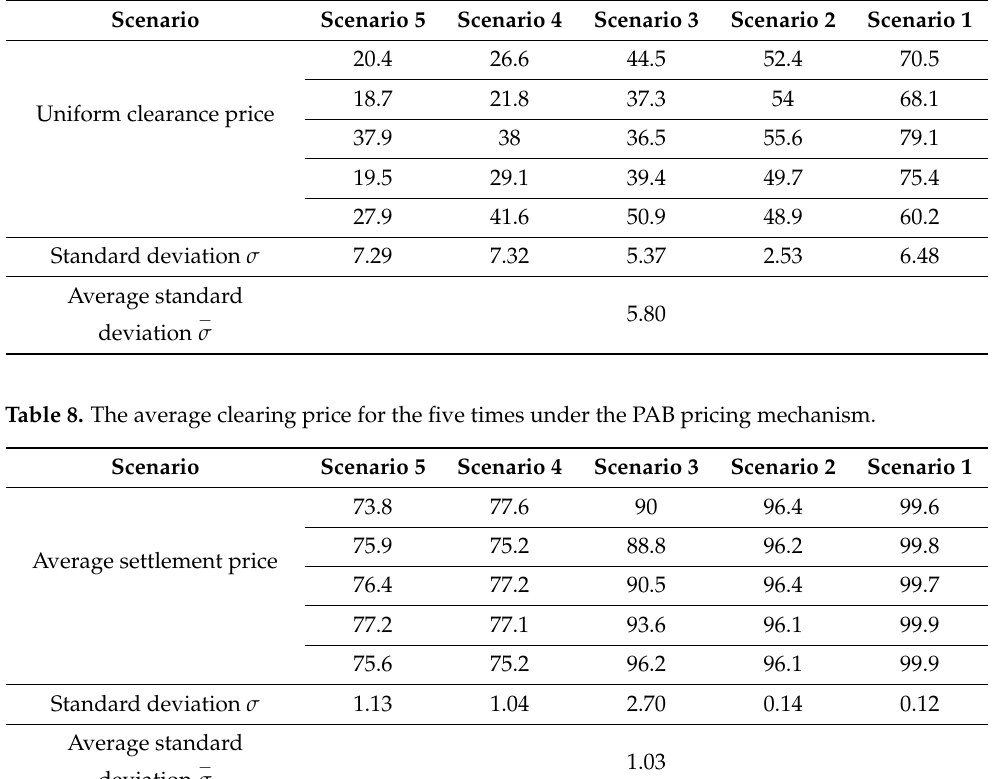
Table 7. Uniform clearance prices for five times under the MCP pricing mechanism.